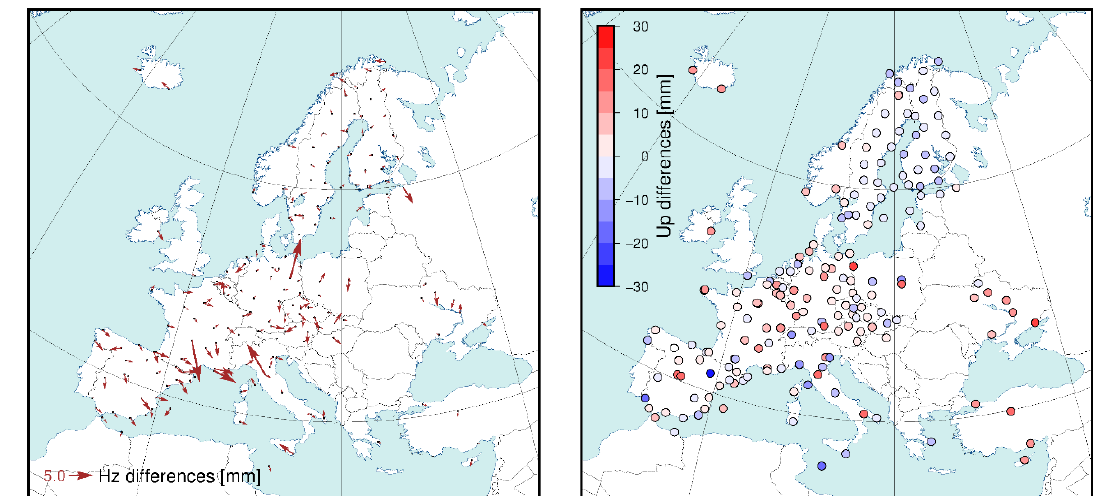
Figure 6. Coordinate differences between solutions E1 and G1 for the DD approach.